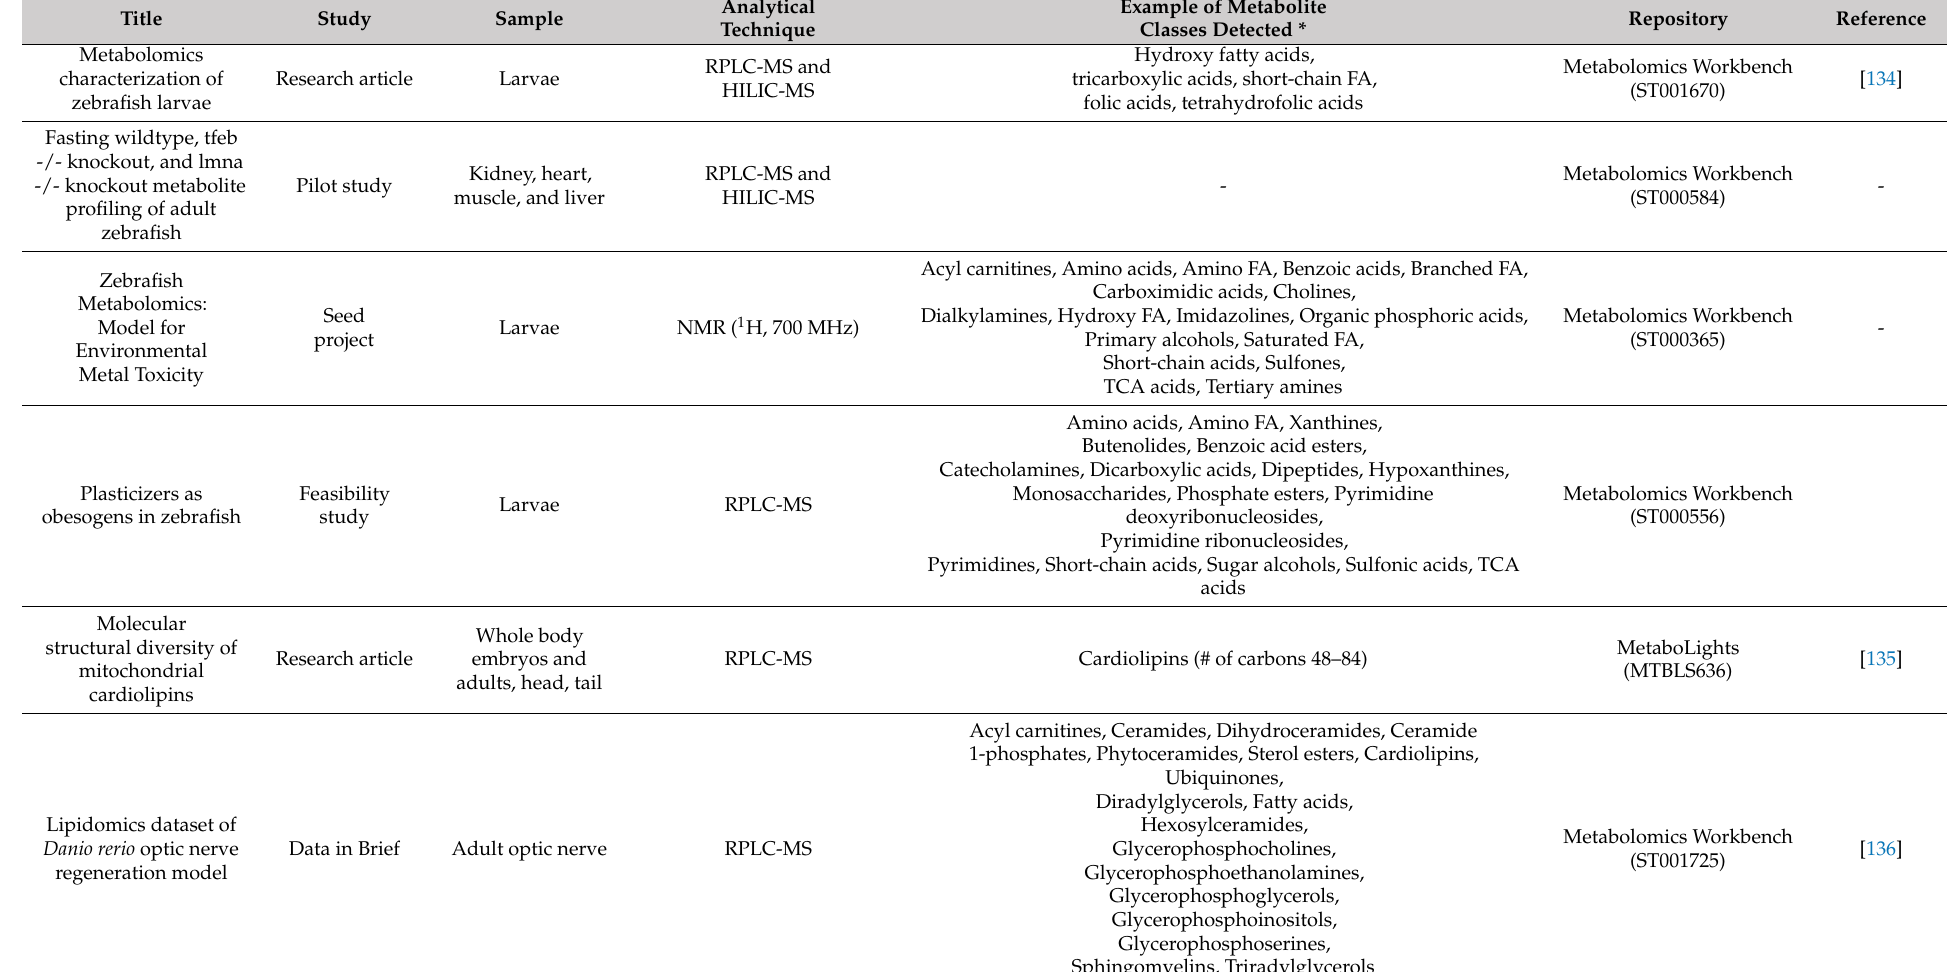
Table 2. Zebrafish studies in publicly available